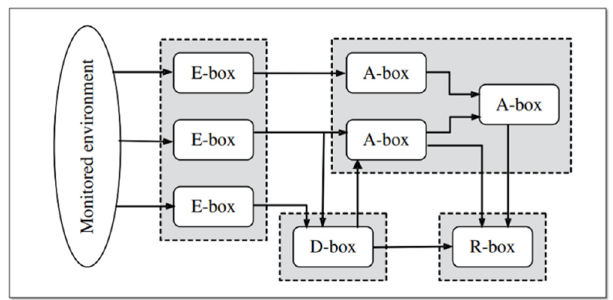
Figure 3. Adaptation of the IDS framework [30].